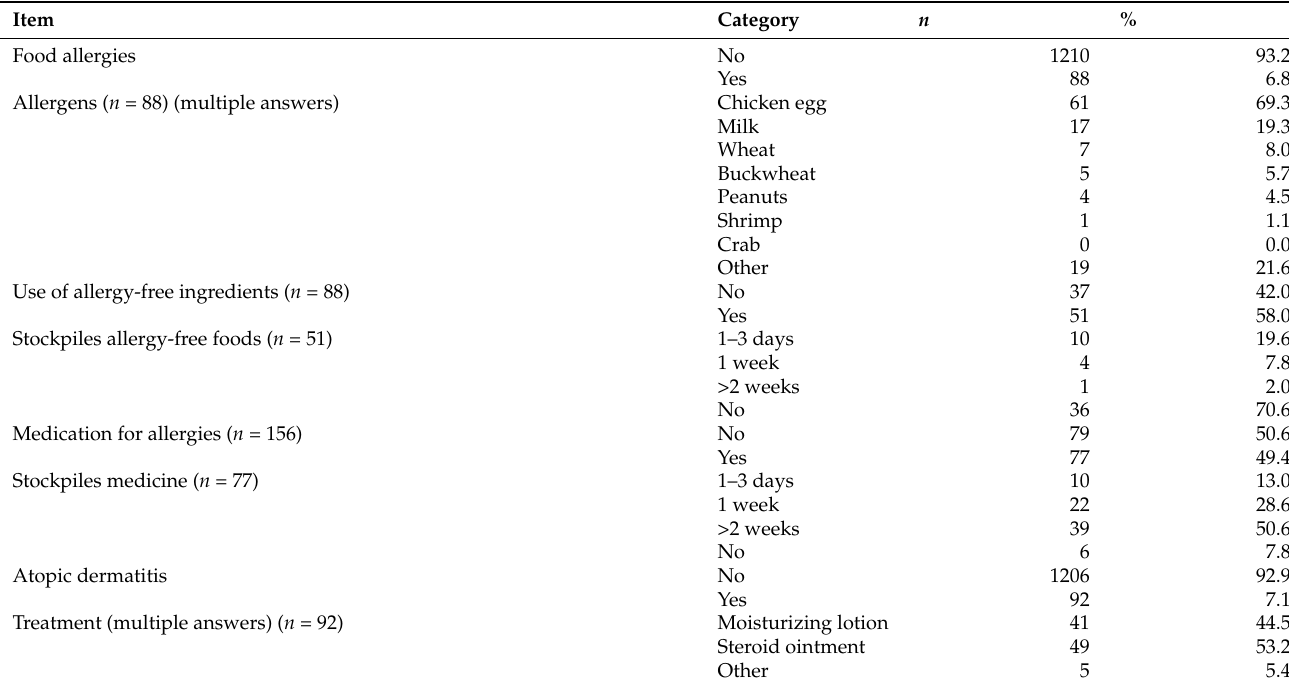
Table 2. Table 2. Types of allergies, allergens, and disaster preparedness ( n =